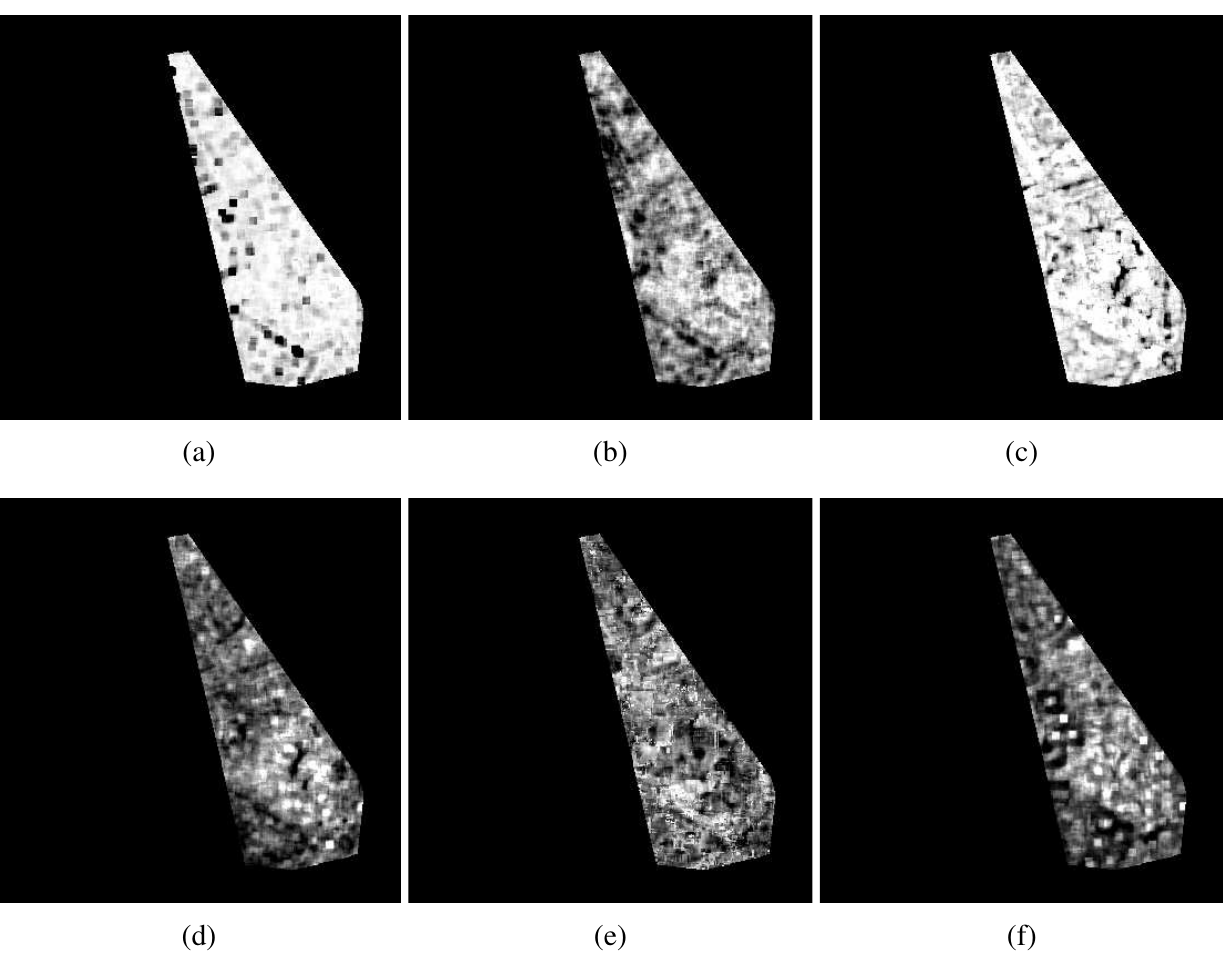
Similarity images of the push-broom and SAR data - case b : (a) distance to independence; (b) mutual information; (c) cluster reward algorithm; (d) Woods criterion; (e) robust Woods criterion; (f) correlation